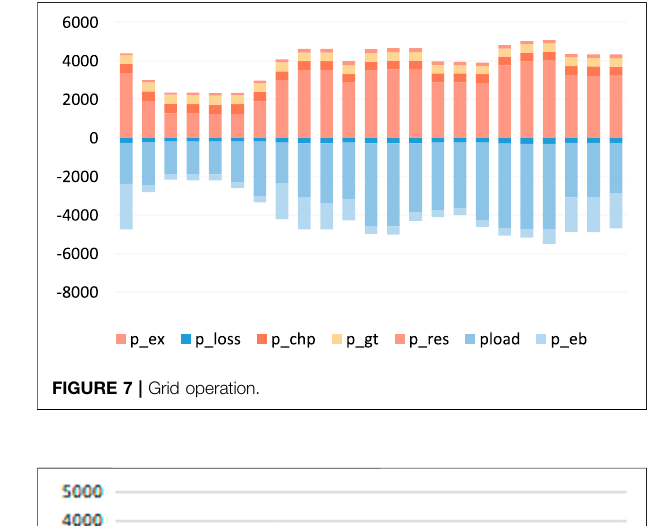
FIGURE 5 | Evaluation loss function curve.